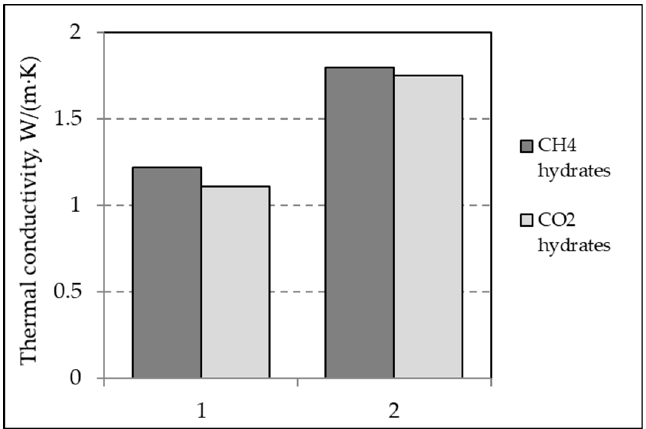
Figure 3. Thermal conductivities of frozen soil samples with CH 4 and CO 2 pore hydrates at t = − 6 ± 1 ° C. 1—fine sand-1, W=15%, K h = 0.33; 2—silty sand, W=22%, K h = 0.18.